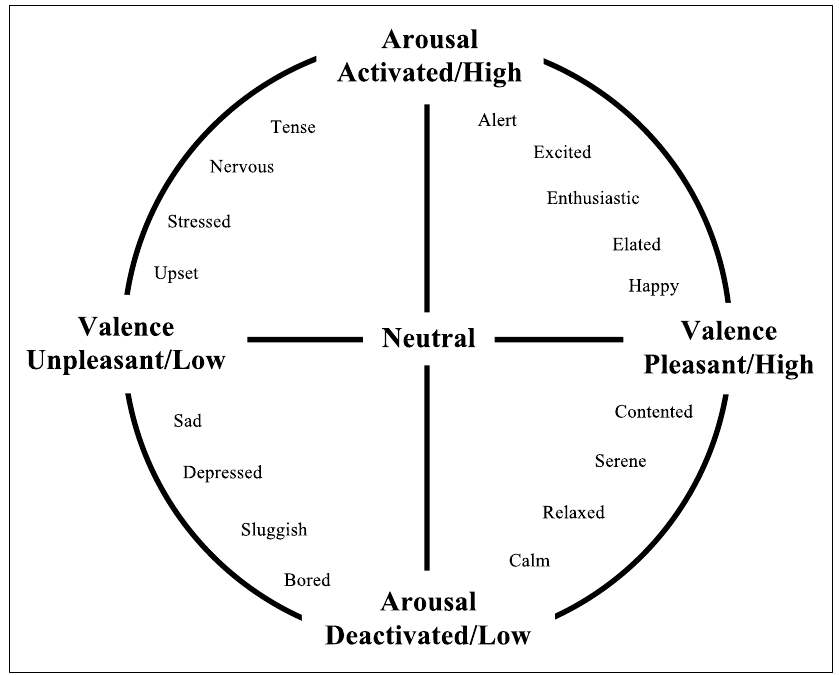
Figure 9. Russell circumplex model [51]